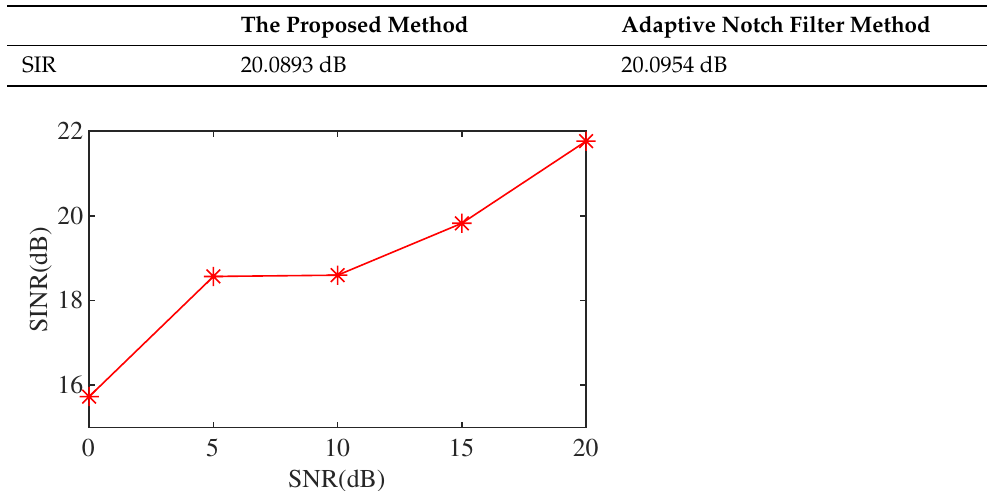
Table 3. The SIR comparison of the proposed method and the adaptive notch filter method.